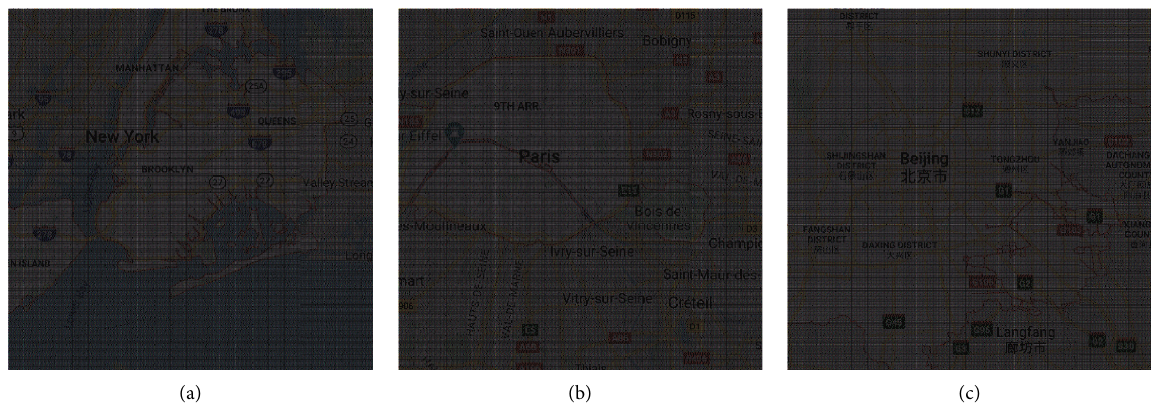
Figure 3: The experimental result and PSNR values of the proposed method on raster maps of (a) New York, (b) Paris, and (c) Beijing cities. The map (c) is superimposed from (a) and (b). (a) 49.62, (b) 49.52, and (c) 49.53.